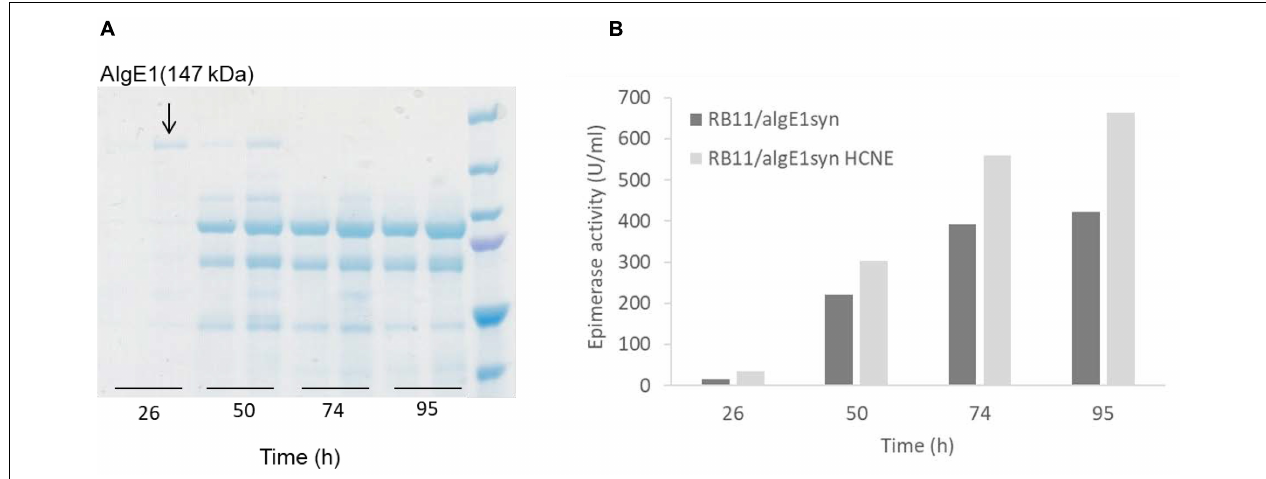
FIGURE 5 | Effect of increased calnexin gene dosage ( HpCNE ) on AlgE1 stability analyzed by SDS-PAGE (A) and epimerase activity (U/ml culture) (B) in RB11/algE1syn and RB11/algE1syn HCNE. Strains were cultivated in 2xYSPG + 1/3HCD (37 ◦ C, pH 6) with feeding solution composed of glucose (60%) and methanol (10% of glucose), and samples were taken at 26, 50, 74, and 95 h. The samples on the SDS-PAGE gel are arranged in the same order as in the bar chart shown in panel B of the figure. Size of protein fragments in standard (right); 250, 150 100, 75, 50, and 37 kDa.